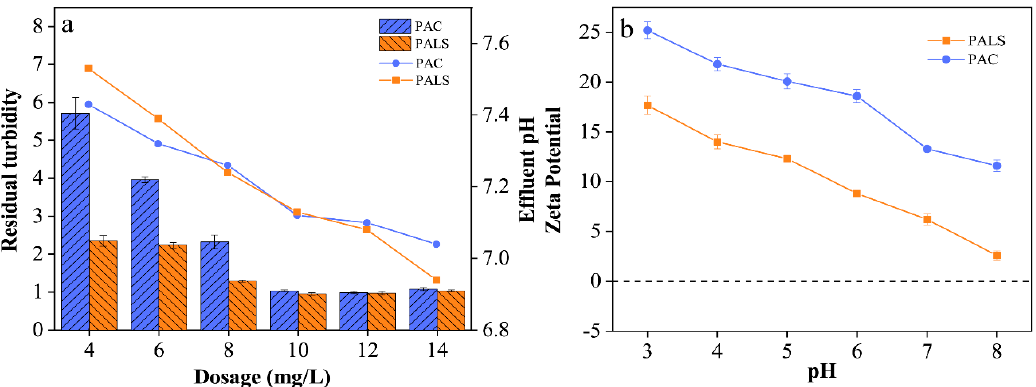
Figure 6. Residual turbidity and effluent pH of raw water from Ri Hu by PAC and PALS ( a ); zeta potential of PAC and PALS at pH 3–8 ( b ).